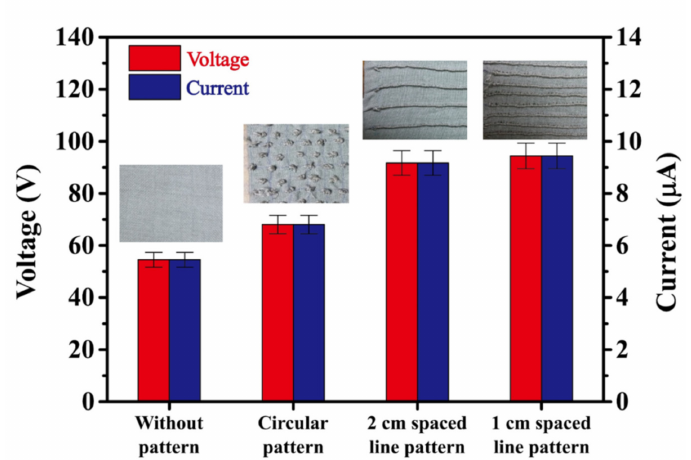
Figure 6. Output voltage and current of TEGs with different CT surface morphologies. The TEGs connected to an external load with a resistor of 10 M Ω